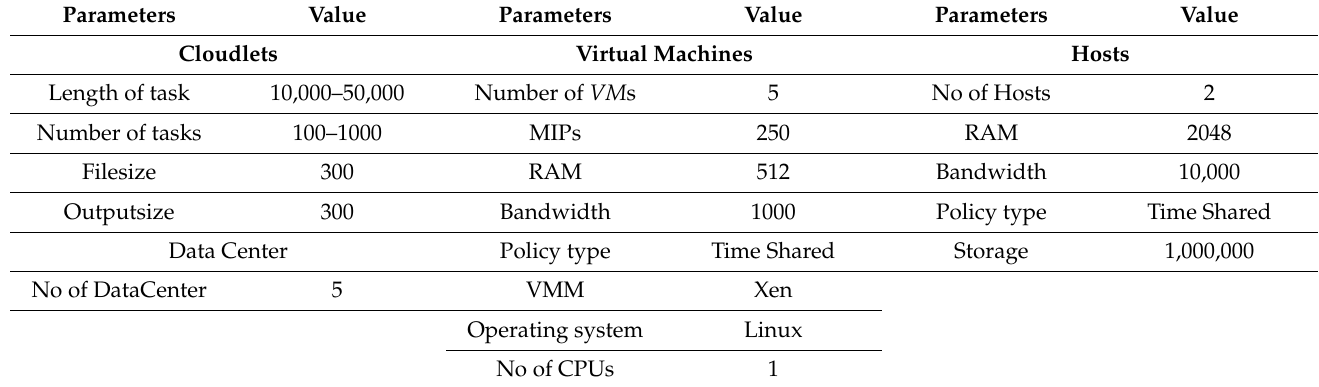
Figure 14. Comparison with heuristic algorithms in terms of the average SD of makespan. Table 2. Parameters of the CloudSim platform.